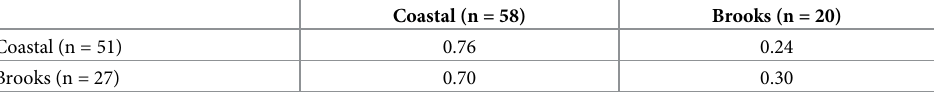
Table 2. Transition probabilities for caribou use of the coastal plain in the north of the study area (Coastal) and the Brooks Range mountains in the south of the study area (Brooks) in subsequent winters.